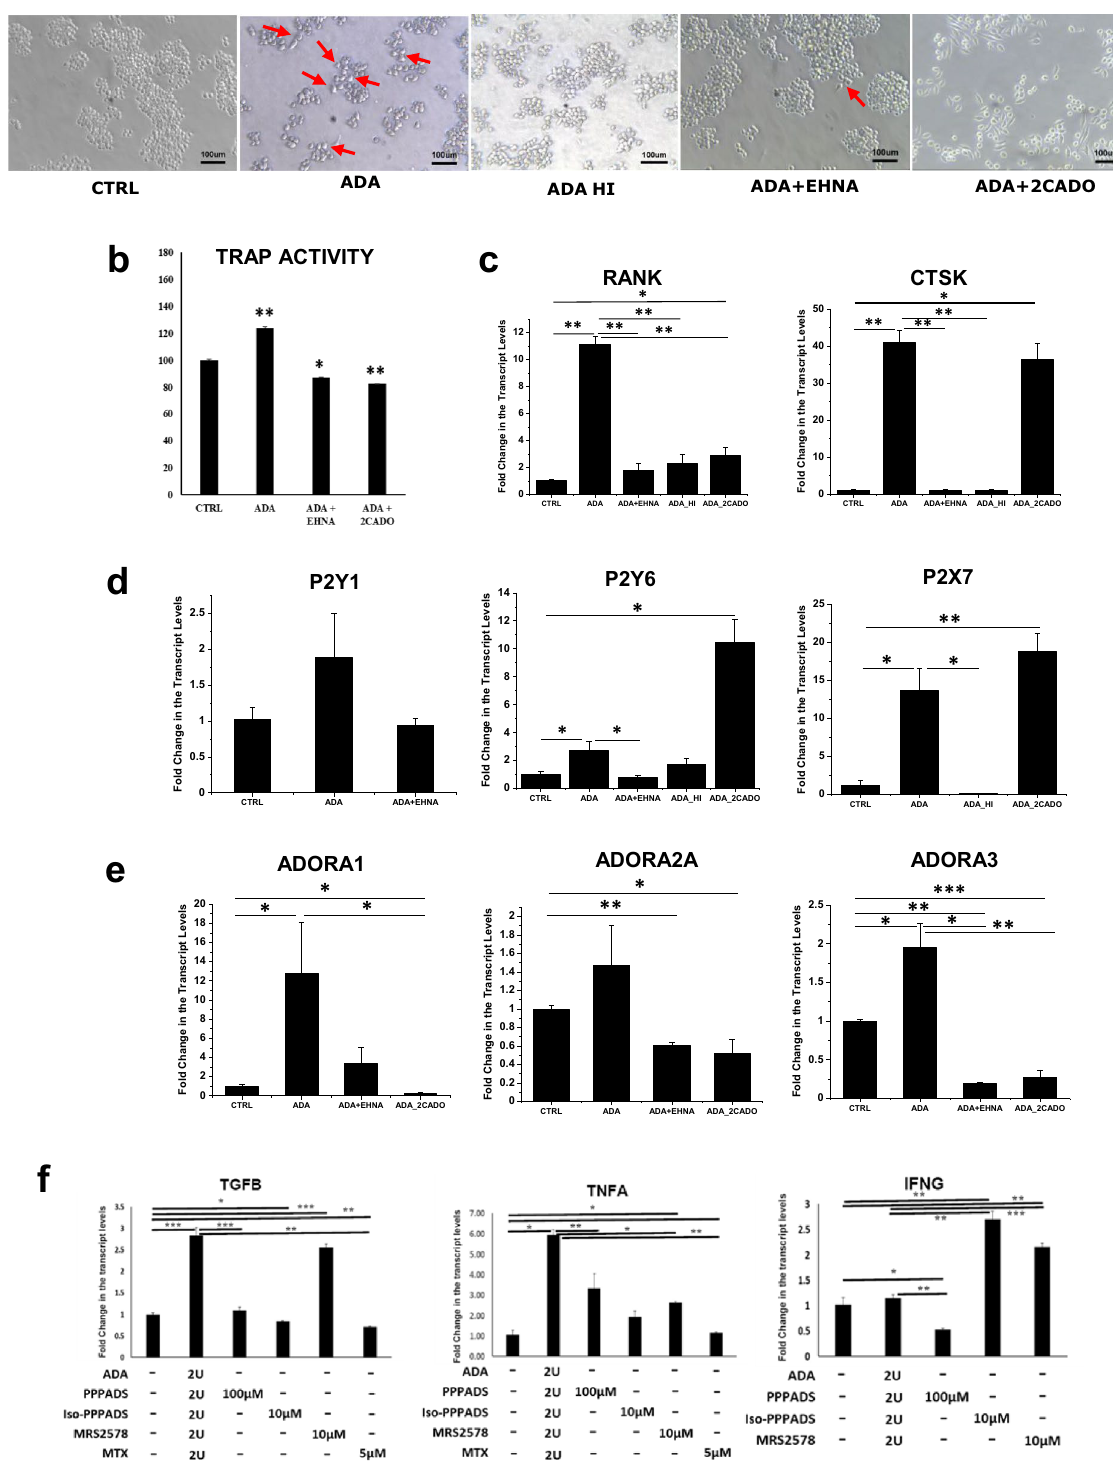
Figure 6. ADA enhances adenosine signaling and purinergic receptor signaling in rheumatoid arthritis. ( a ) Osteoclast differentiation is reduced after exposure to EHNA (ADA blocker) and 2CADO (adenosine analog) in macrophages. ( b ) Reduced TRAP activity after the treatment with EHNA and 2CADO confirming the role of ADA in osteoclast differentiation. ( c ) Decreased expression of osteoclast markers CTSK and RANK in macrophages after exposure to EHNA and 2CADO. ( d ) Decreased expression of P2Y receptors after exposure to EHNA and 2CADO along with ADA shows involvement of P2Y receptors in osteoclast differentiation. ( e ) Enhanced Adenosine signaling with the exposure of ADA in macrophages leading to increased expression of adenosine receptors. ( f ) Decreased expression of inflammatory genes after exposure to P2 receptor antagonists in the presence of ADA (showing *representing a p value of ≤ 0.05, and **representing a p value of ≤ 0.005, ***representing a p value of ≤ 0.0005). All the plots were made using Origin